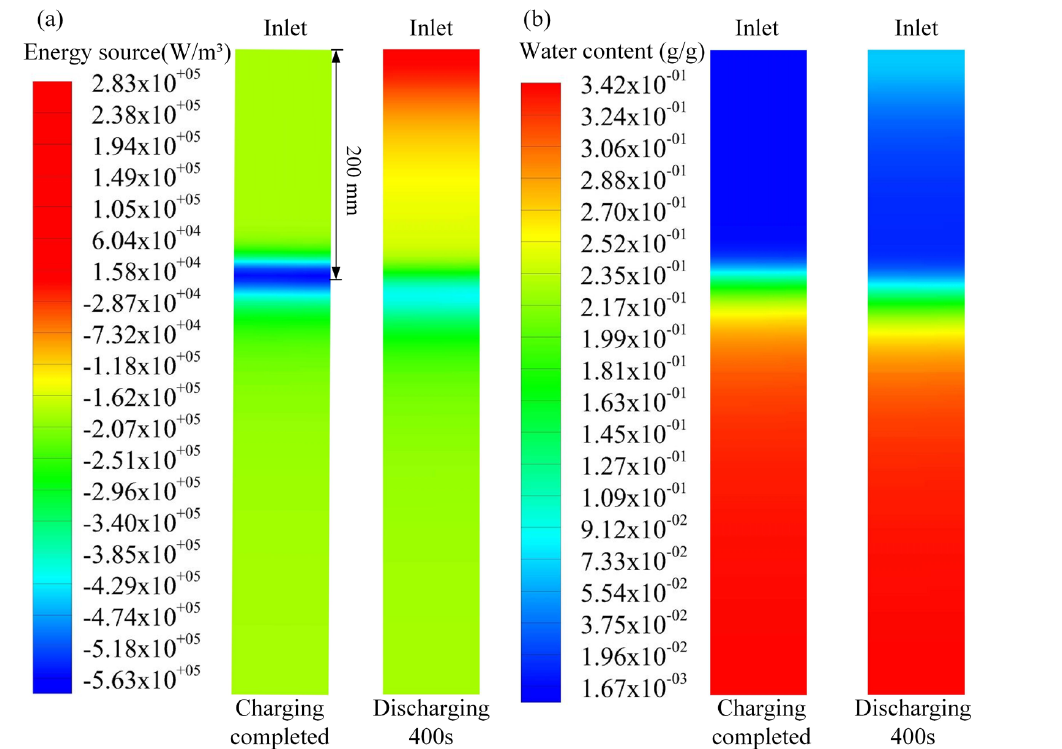
Figure 7. Temperature at air outlet varies with time when ( a ) the direction of the charging and dis- charging air flow is the same and ( b ) the direction of the charging and discharging air flow is oppo- site.